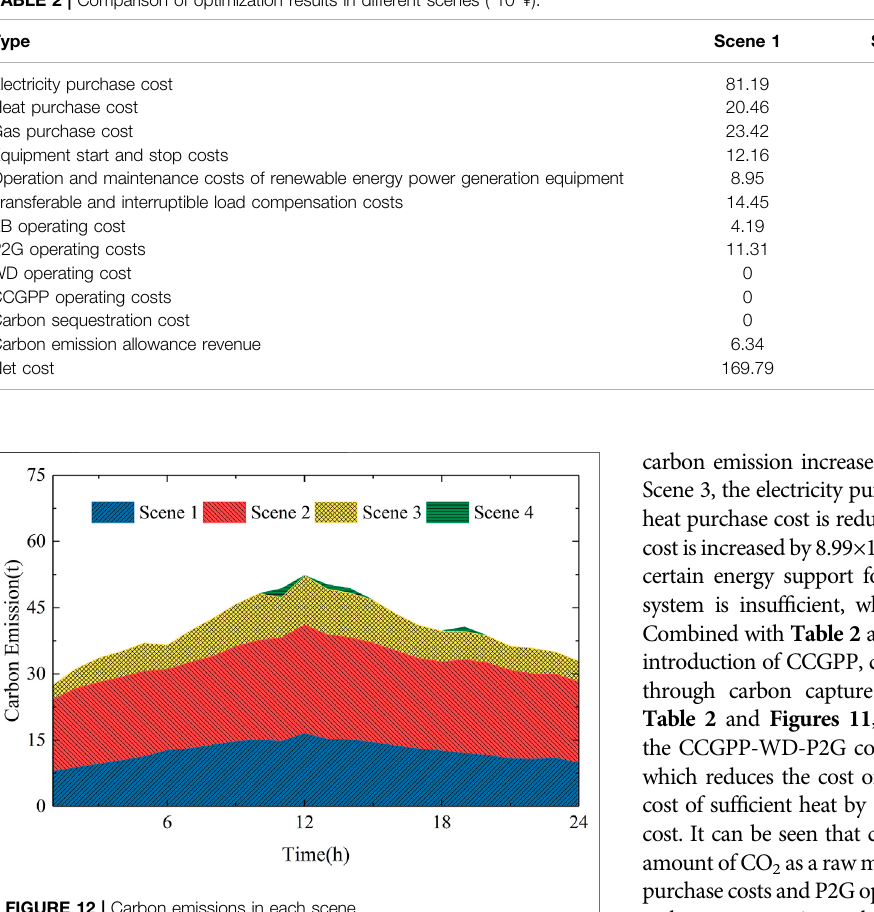
FIGURE 12 | Carbon emissions in each scene.